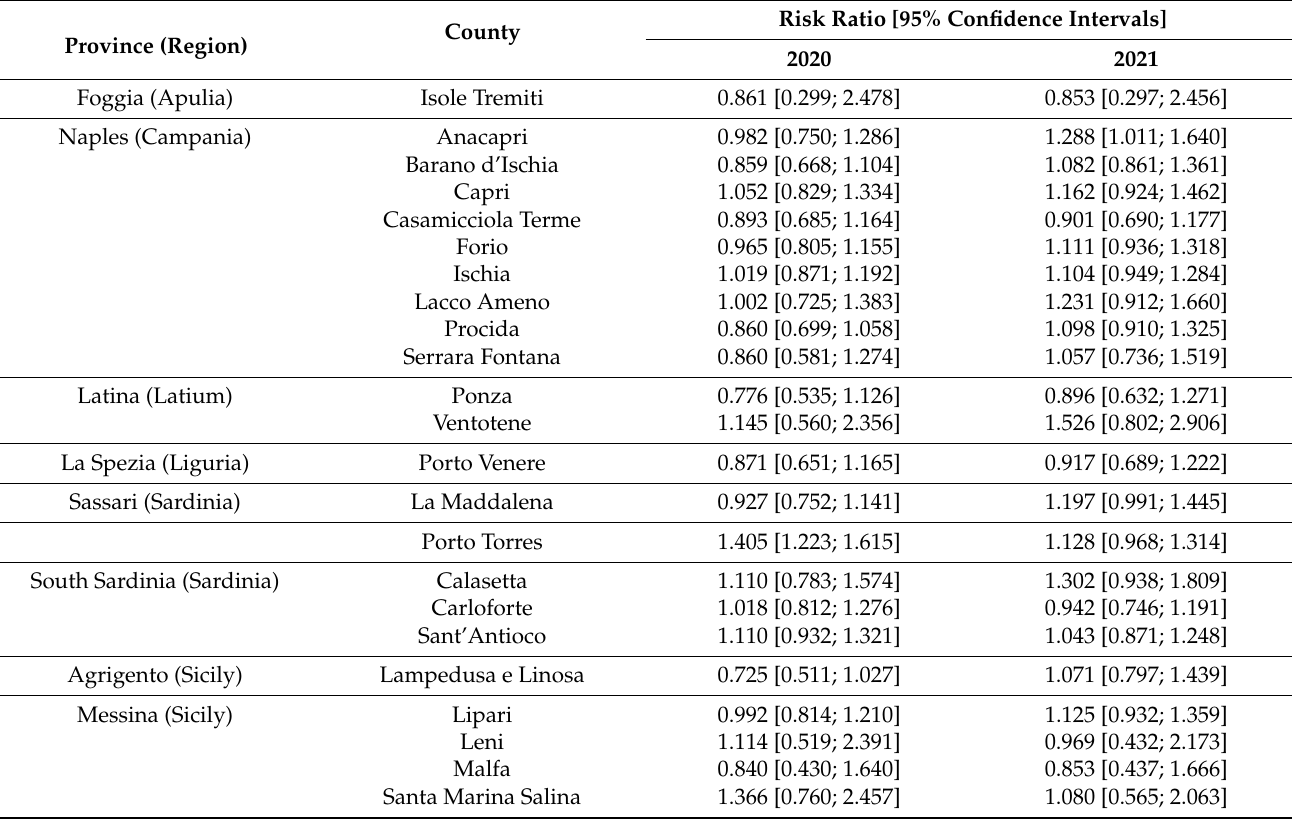
Table 3. Risk ratio for all-cause mortality on Italian small islands in 2020 and 2021 assuming estimates for 2018–2019 as a